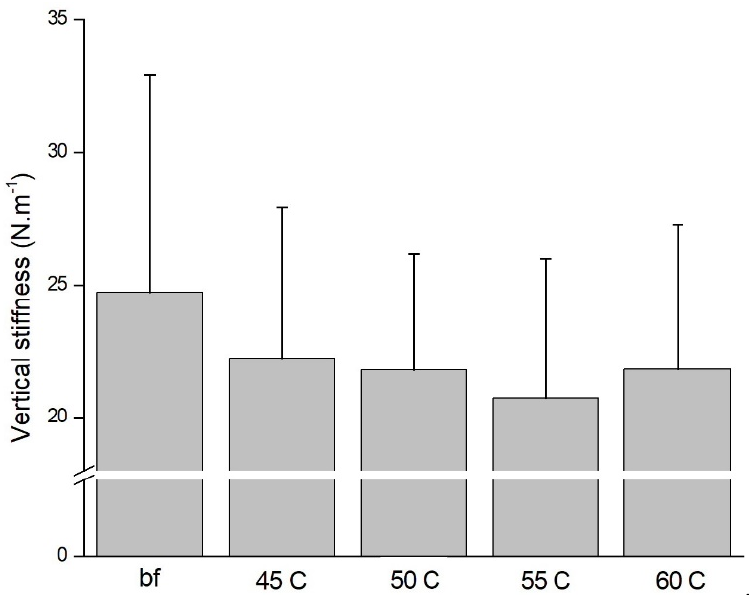
Figure 5. Vertical stiffness in different midsole hardness during jump rope exercise.